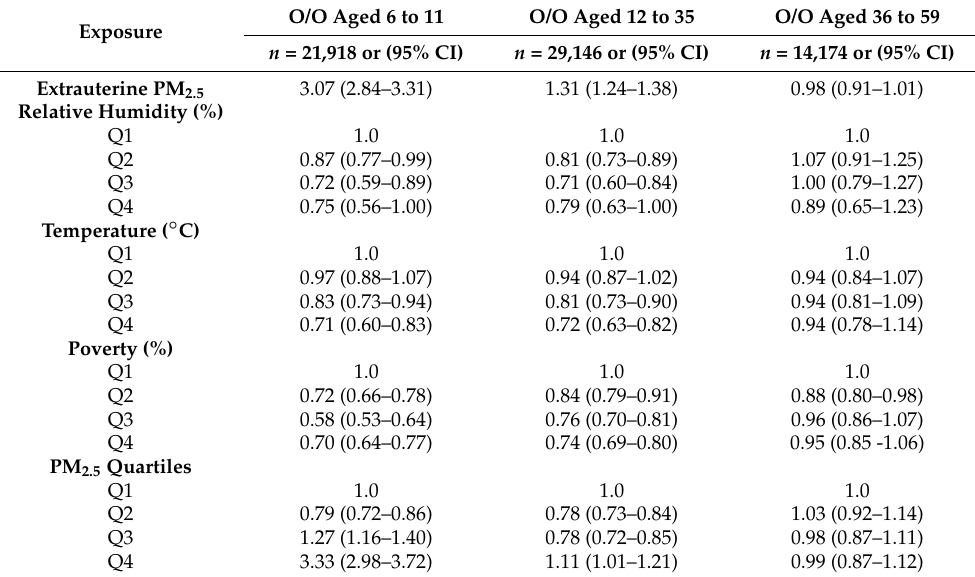
Table 5. Odds ratios for O/O for a 10 µ g/m 3 increase in PM 2.5 for extrauterine exposure using a 6-month exposure window by age group.